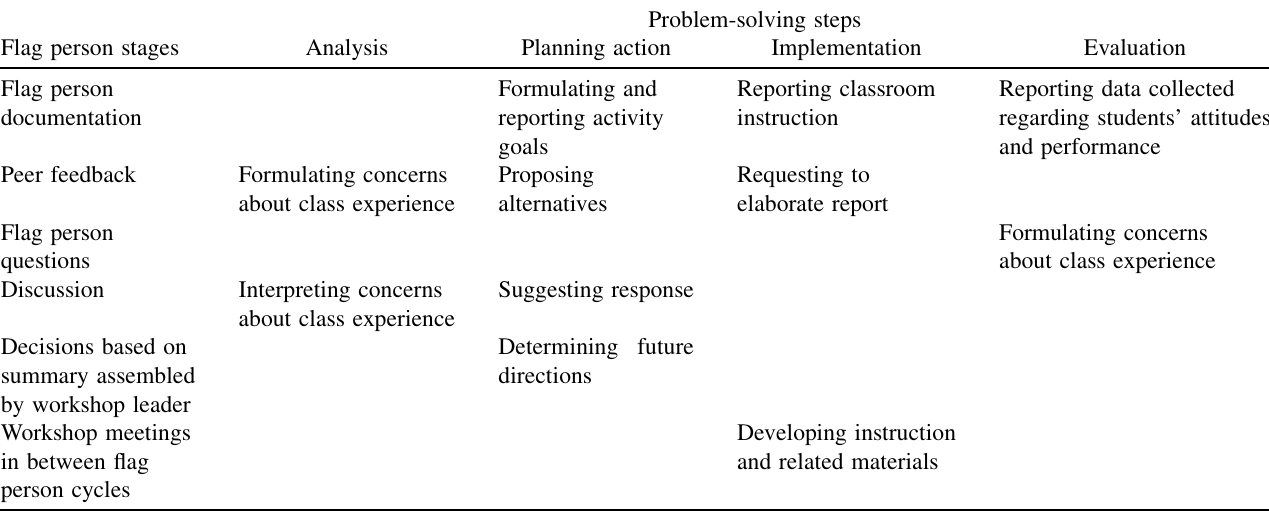
TABLE VII. Pedagogical problem-solving steps embedded in the flag person